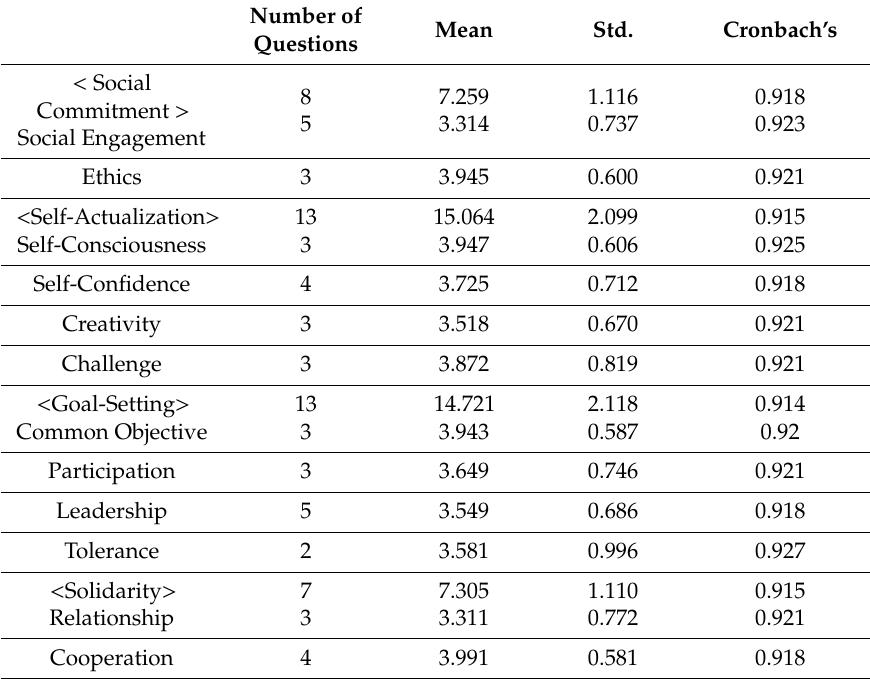
Table 3. Descriptive Statistics and Cronbach’s